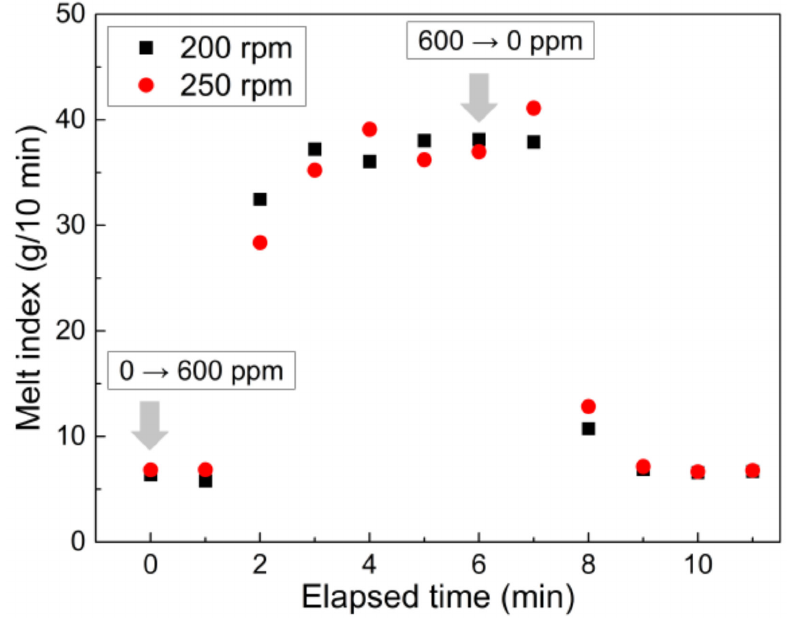
Figure 6. Real-time variation of melt index after step changes of peroxide content in input polymer materials (0 → 600 ppm and 600 → 0 ppm) under extrusion conditions of 215 ◦ C as well as 200 and 250